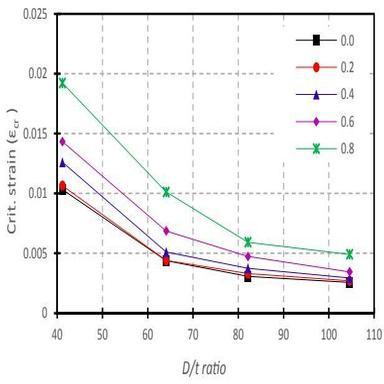
Plot of εcr vs. D/t ratio for RHT X52 pipe (PL/US = 0.81).